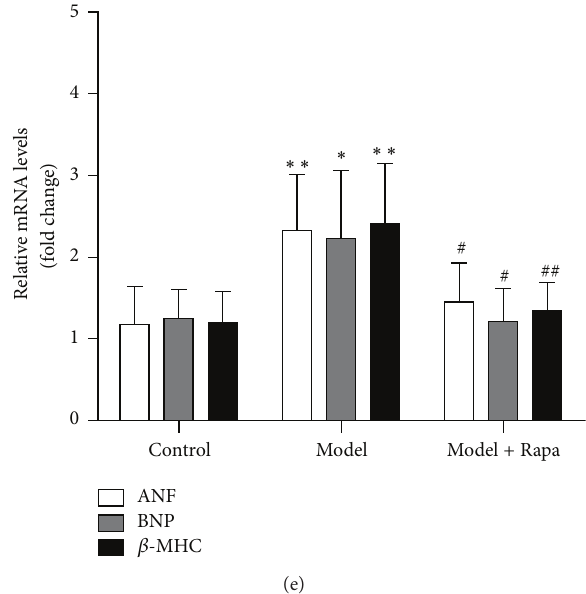
Figure 1: Rapa attenuated cardiac hypertrophy induced by consecutive infusion of isoproterenol. (a) Changes in the ratio of heart weight to body weight (HW/BW) and the ratio of left ventricular weight to body weight (LVW/BW). Values represented mean ± SD of 6 rats in each group. (b) Representative high magnification ( × 400) of left ventricular stained with hematoxylin and eosin from each group. (c) Mean myocyte diameter was calculated by randomly measuring 100 cells from 5 sections in each group. (d) The thickness of left ventricular anterior and posterior wall (left) and left ventricular fraction shortening and left ventricular ejection fraction. Echocardiographic measurements were performed, and values represented as mean ± SD of 6 rats in each group. (e) Gene expression patterns of ANF, BNP, and 𝛽 -MHC among different groups. The mRNA was prepared and normalized to GAPDH gene. Model, the cardiac hypertrophy model induced by isoproterenol; Rapa, isoproterenol-infused rats treated with Rapa. Values represented as mean ± SD of 4 to 5 rats in each group. ∗ 𝑃 < 0.05 versus control group; ∗∗ 𝑃 < 0.01 versus control group; ∗∗∗ 𝑃 < 0.001 versus control group; # 𝑃 < 0.05 versus model group; ## 𝑃 < 0.01 versus model group; and ### 𝑃 < 0.001 versus model